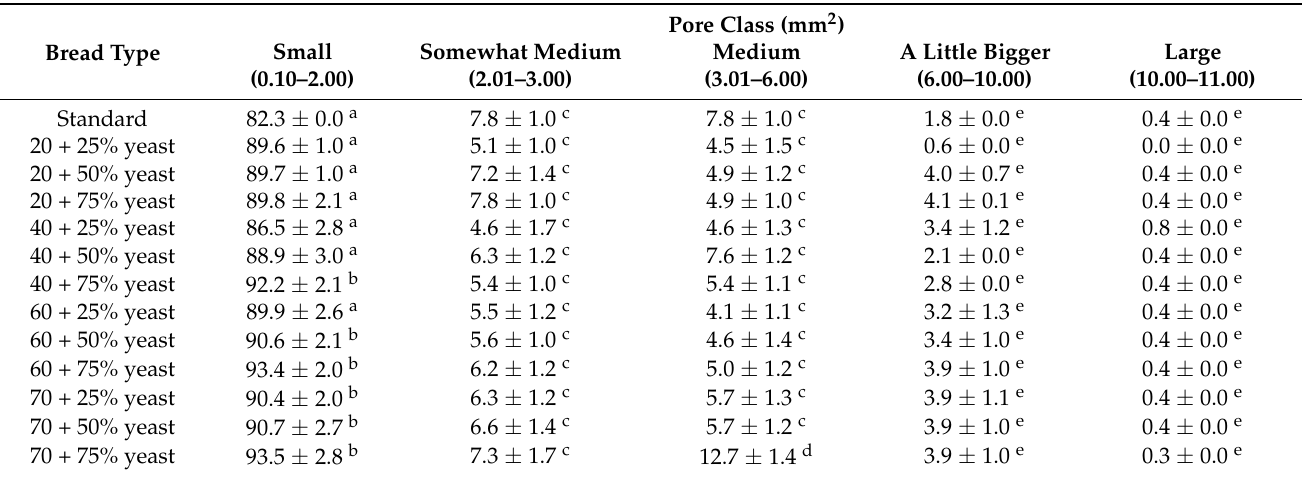
Table 4. Pore size analysis of standard bread versus the GH breads with promoters (20–70%) and 25–75% yeast as partial